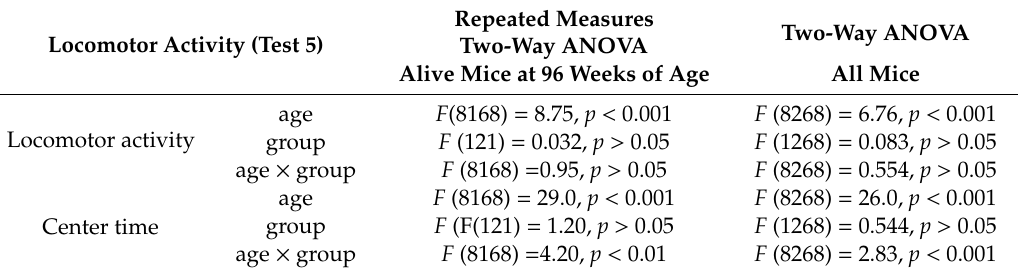
Figure 7. Changes in locomotor activities under 25 lux with aging in the chamber and IVC groups (Test 5): ( A ) locomotor activities; ( B ) center time. There was no significant difference between both groups using two-way ANOVA. ††† p < 0.001 by Bonferroni’s post-hoc test for multiple comparisons. Table 3. Results of statistical analysis in Test 5.